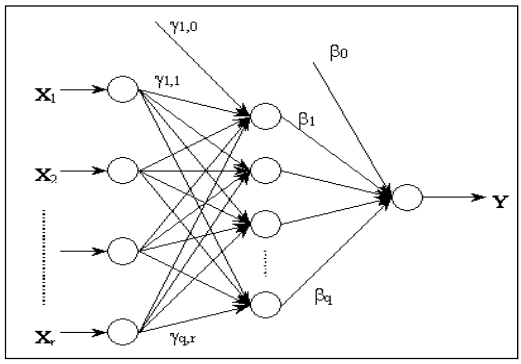
Figure 3. General representation of the network execution process.